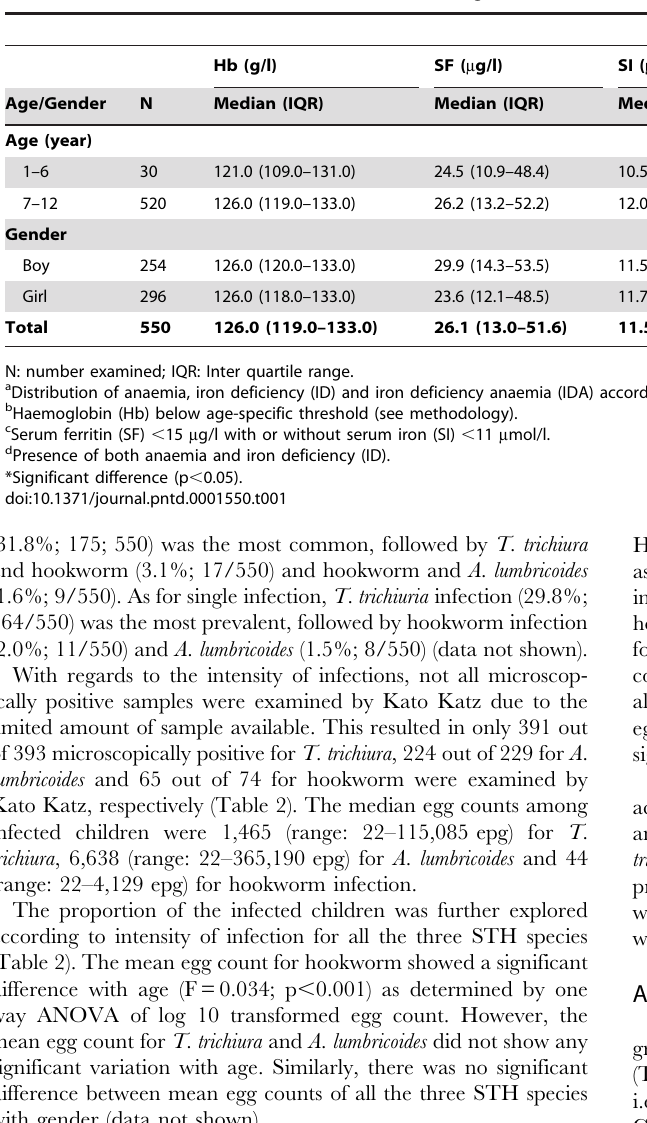
Table 1. Distribution of serum iron status among rural children in West Malaysia (N =550) a .